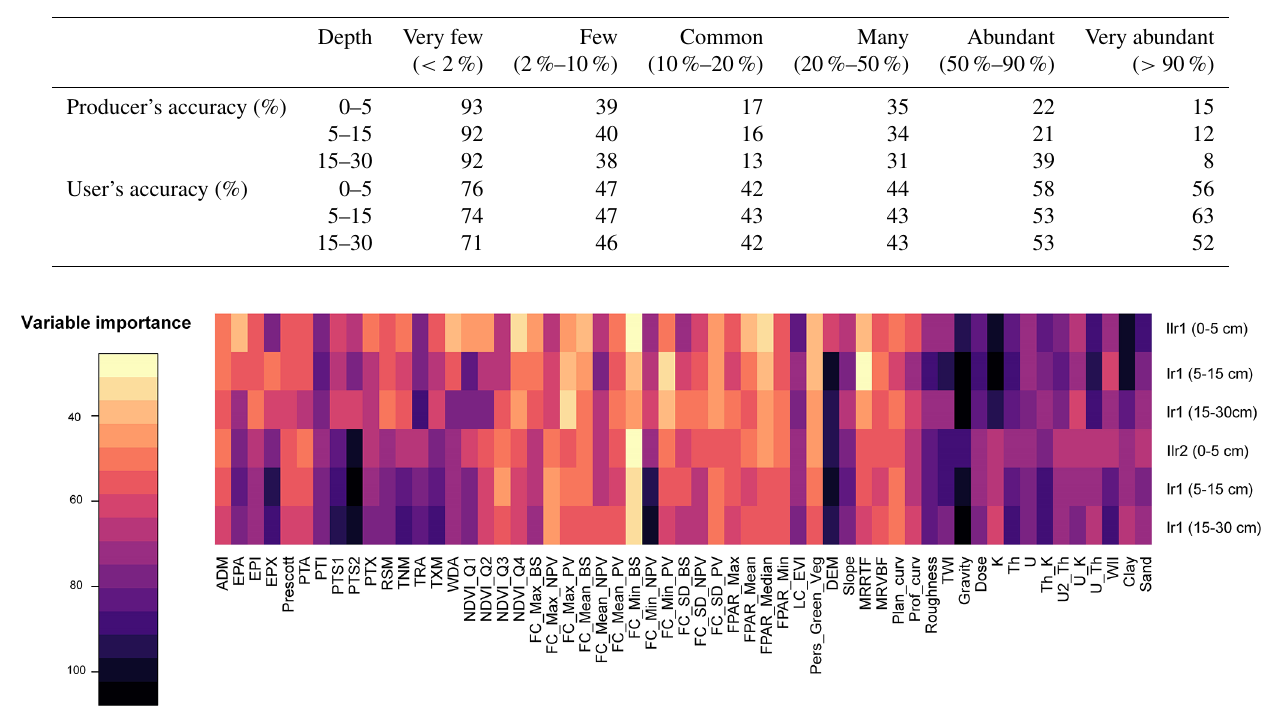
Table 4. Cross-validation statistics for classification of coarse fragments (%vol).